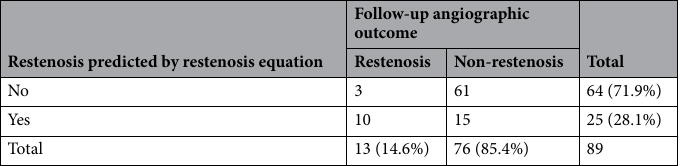
Follow-up angiographic outcome TotalRestenosis Non-restenosis